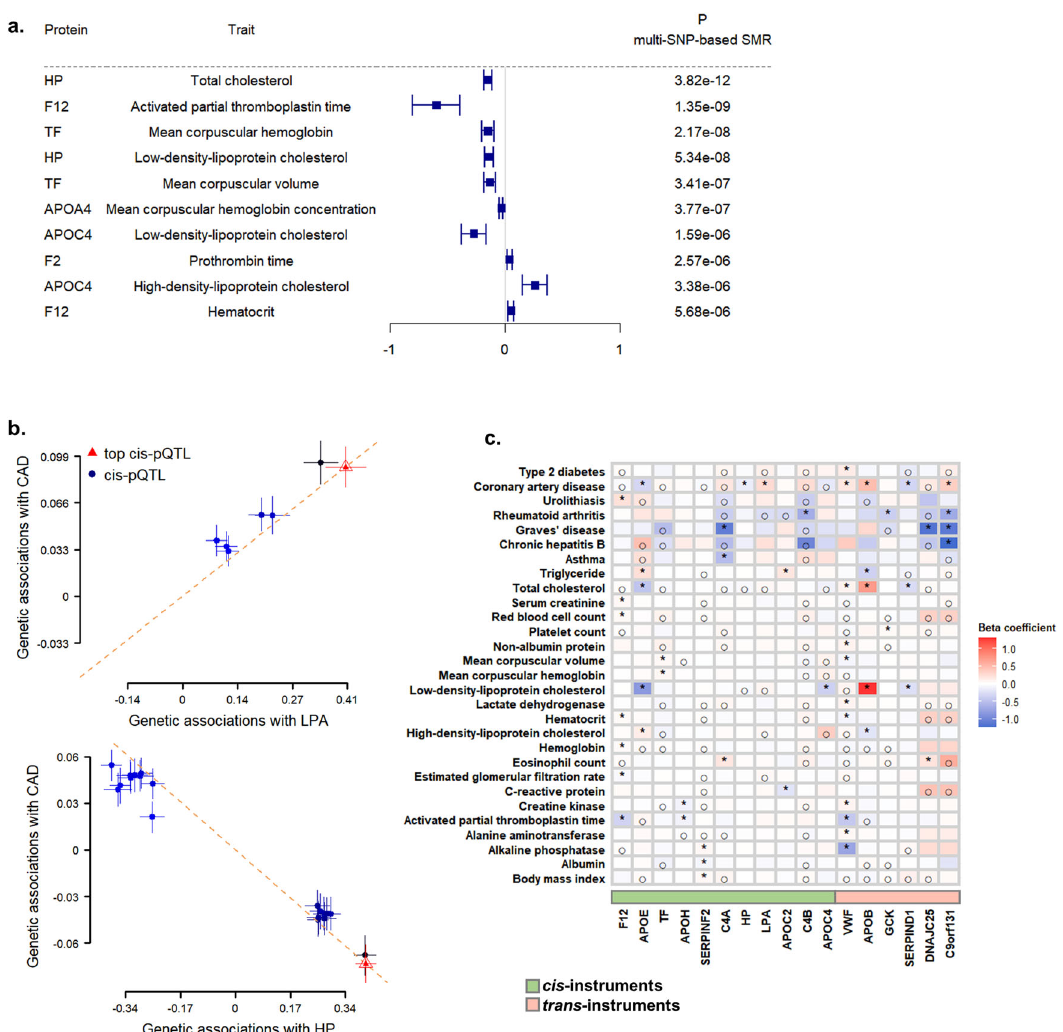
Fig. 5 | Associations between proteins and clinically relevant phenotypes. a Colocalization of cis -pQTLs and the clinical traits. The squares represent the estimated effect size from the summary-data-based Mendelian randomization analysis, and the lines represent the 95% con fi dence intervals. b Effect sizes from disease GWAS studies against those from pQTL summary statistics. The orange dashed lines show the estimate at the top cis -pQTL. The error bars represent the